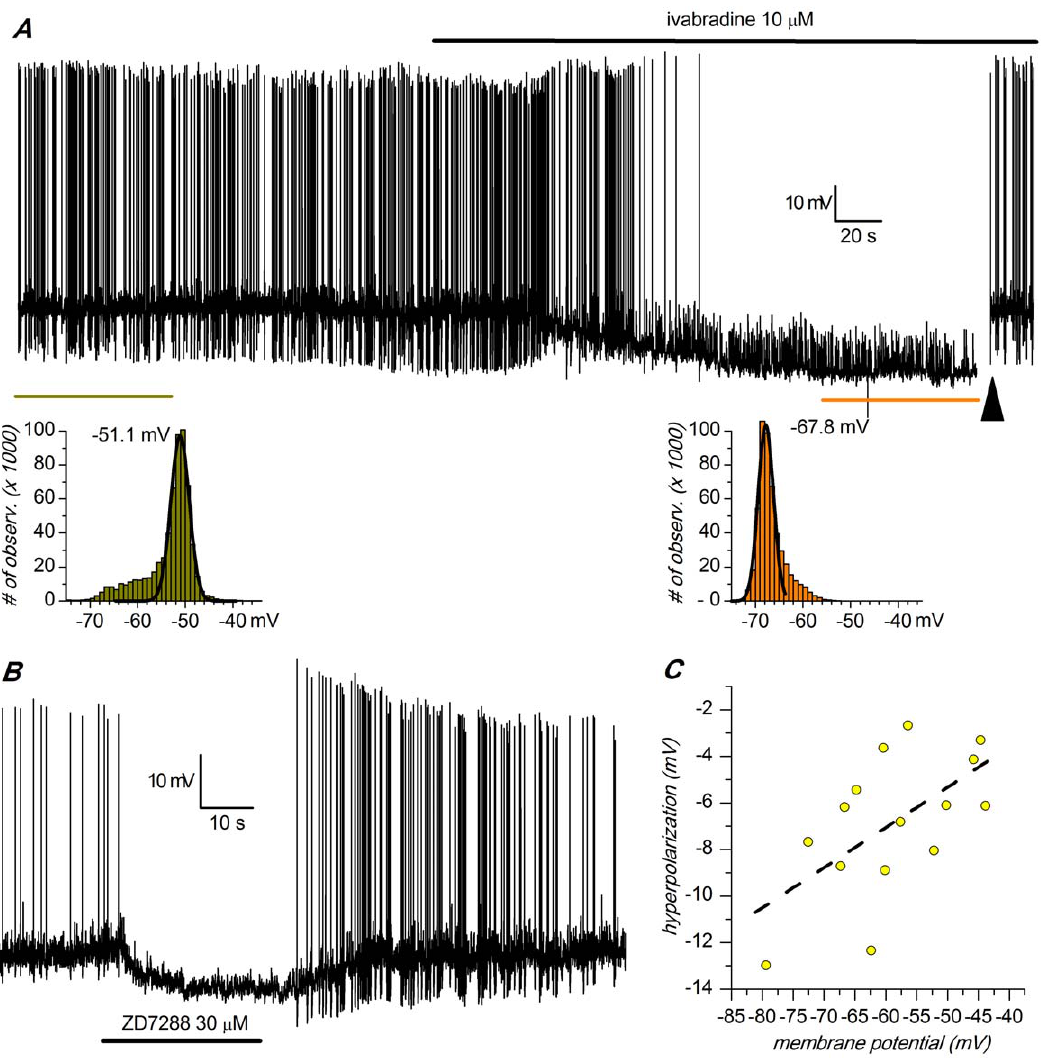
Figure 6. Role of Ih in autorhythmicity. A: Current-clamp recording (perforated patch, 37 u C) showing the hyperpolarizing effect of a selective, non voltage-dependent blocker of the h-current (ivabradine 10 m M, applied focally at the moment indicated by the arrow) on spontaneous activity. The two insets below illustrate the method used for the determination of the ‘‘resting’’ membrane potential in spontaneously active cells: the value was actually measured as the prevailing potential, measured by fitting a Gaussian to the membrane potential values in the time intervals marked by the bars of the same color. At the time marked by the large arrow to the right, the membrane was manually depolarized to the value antecedent the ivabradine application, restoring the spontaneous activity and thereby showing that the h-current is not essential for the pacemaking mechanism. B: Same experiment using ZD7288 30 m M. C: Relationship of the hyperpolarizing effects obtained with ZD7288 with the resting membrane potential, showing a significant correlation (p , 0.02;